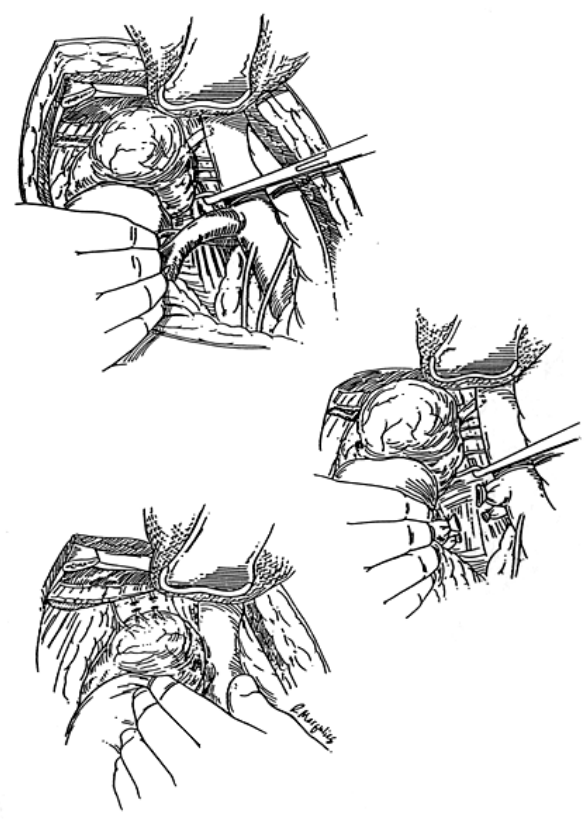
FIGURE 10. Removal of large right adrenal tumor and